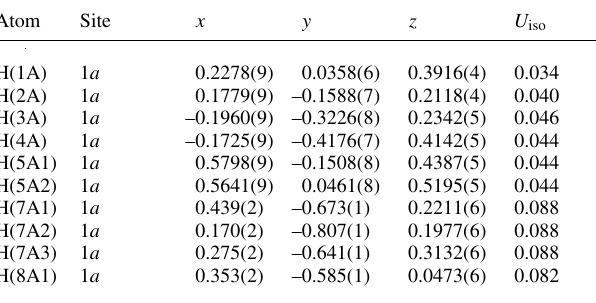
Table 2. Atomic coordinates and displacement parameters (in Å 2 )